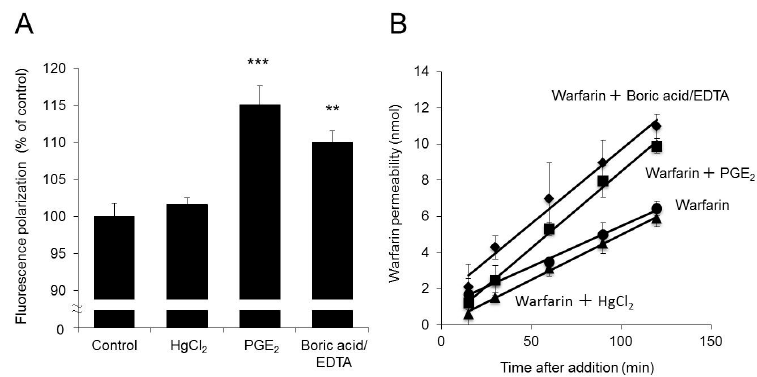
Figure 6. Effects of increased membrane fluidity on warfarin permeability. Caco-2 cells were plated in Transwell plates and incubated for 21 days. ( A ) HgCl 2 , PGE 2 , or boric acid/EDTA was added to the apical side of the Transwell plate. The fluorescence polarization of 1,6-diphenyl-1,2,5-hexatriene (DPH) was then calculated and expressed as a percentage of the control value, which was set as 100%. ( B ) Warfarin alone or a combination of warfarin and HgCl 2 , warfarin and PGE 2 , or warfarin and boric acid/EDTA was added to the apical side of the Transwell plate. The concentration of warfarin on the basal side was measured. The data are presented as the mean ± SD for six experiments. Dunnett’s test: ** p < 0.01 and *** p < 0.001 vs. the control value.